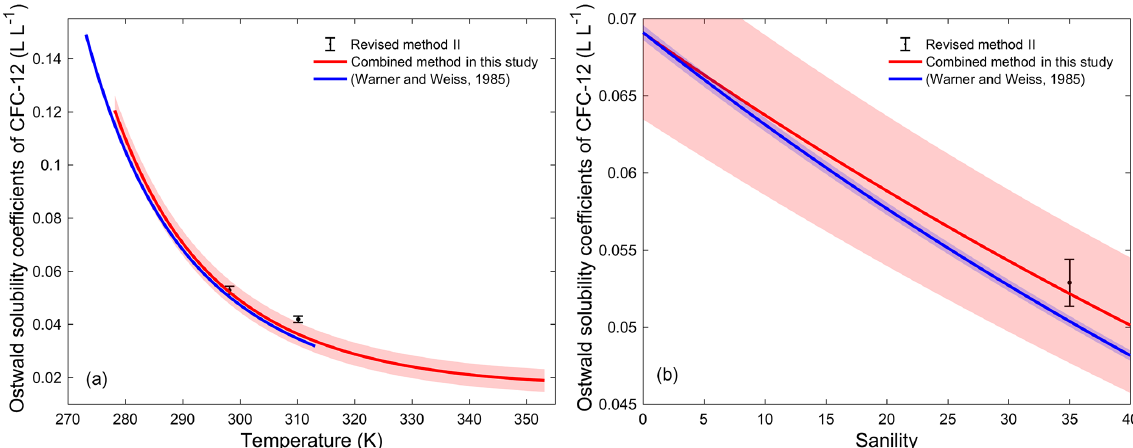
Figure 5. Comparison of the Ostwald solubility coefficients in seawater for CFC-12 (a) in the available temperature range at a salinity of 35 and (b) in the salinity range of 0–40 at a temperature of 298.15K calculated from revised method II, from the combined method, and from Warner and Weiss (1985). Error bars and shadings in the figure reflect the